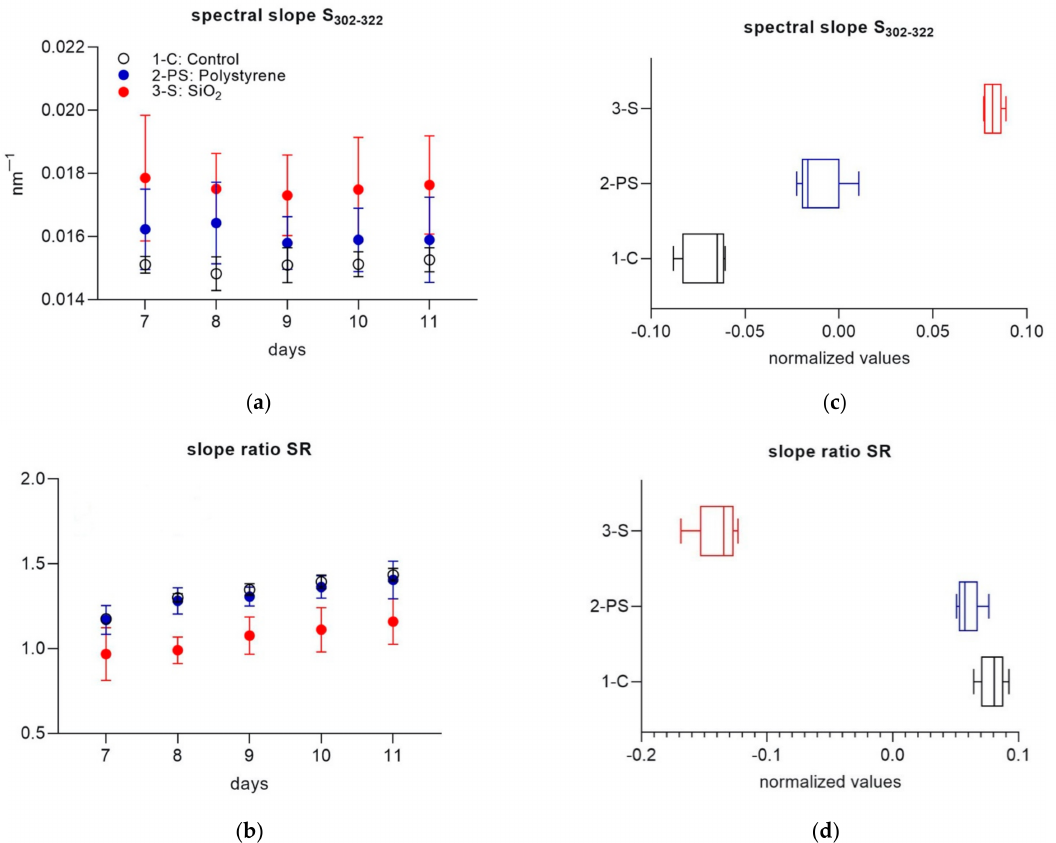
Figure 3. Daily values of spectral slope S 302–322 ( a ) and slope ratio (SR) ( b ) for each treatment during part 2 of the experiment. Each data point is the average of four replicate cuvettes ( ± standard deviation); Normalized daily anomalies per each treatment during experimental part 2 for spectral slope S 302–322 ( c ) and slope ratio (SR) ( d ). Box plots have the following color code: 1-C (black line), 2-PS (blue line) and 3-S (red